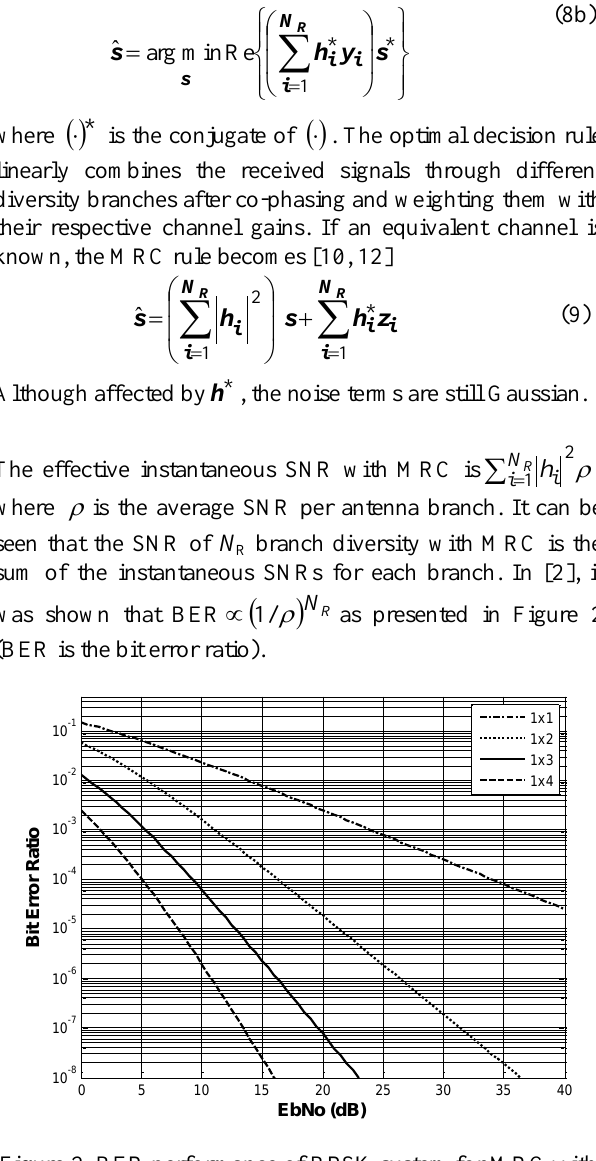
Figure 2: BER performance of BPSK system for MRC with an increasing number of